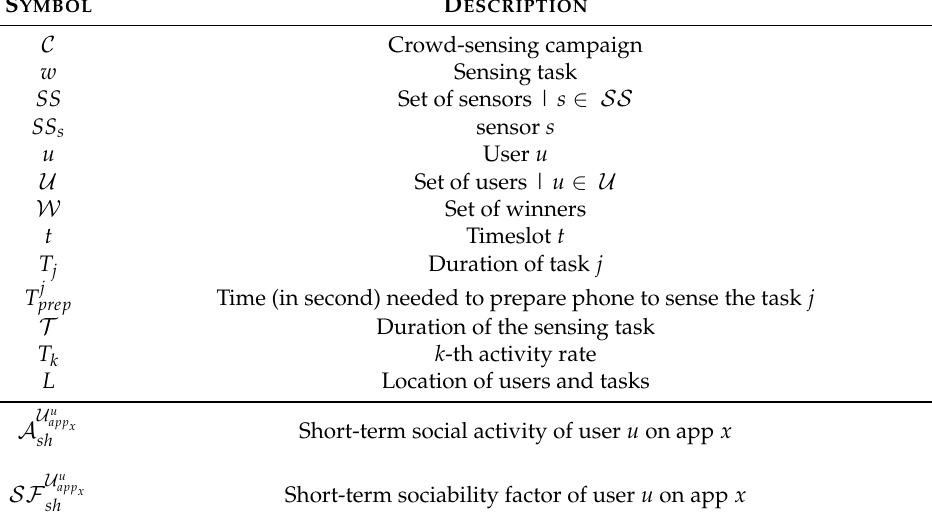
Table 1. Description of symbols. The notation in [41] has been partially